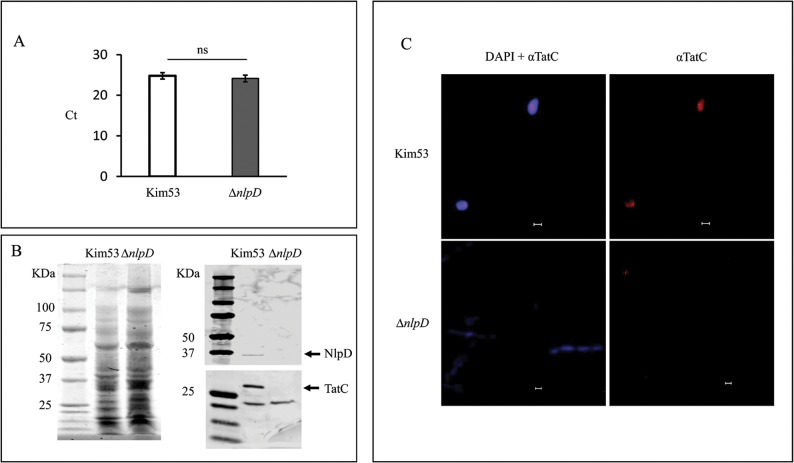
Expression of TatC in the Y. pestis strains.A. Quantitative RT-PCR analysis of tatC mRNA levels. mRNA from Kim53 (white histogram) and the nlpD mutant (gray histogram) was subjected to qRT-PCR analysis of tatC gene expression. The relative mRNA level was determined by calculating the threshold cycle (ΔCt) of target genes via the classic ΔCt method [90]. The results presented are an average of three independent experiments. B. Western blot analysis of TatC protein levels in total cell lysates of the wild-type Kim53 strain and the nlpD mutant. Whole cell lysates (106 cfu/lane grown at 37°C), were subjected to Western blot analysis using anti-NlpD and anti-TatC antibodies. The Coomassie blue stained gel and the blots were derived from the same experiment and were processed in parallel. C. Distribution of TatC protein on the bacterial membrane of Y. pestis strains. Fluorescence microscopy images of wild-type Kim53 (top panel) and the nlpD mutant (lower panel) are presented after TatC staining alone (right panel) or with DAPI staining (left panel). Images (100×) were captured with a Zeiss LSM 710 confocal microscope (Zeiss, Oberkochen, Germany). Scale bar = 1 μm. The inset shows a magnification (×3) of stained bacterial cells. The data presented are representative of at least two independent experiments and the displayed data is one representative experiment.